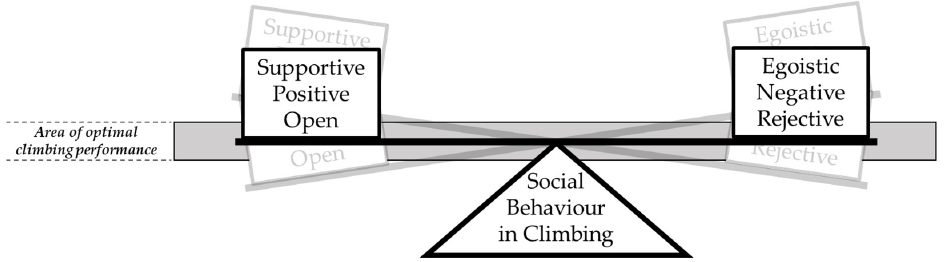
Figure 1. Concept of balanced behaviour. The bar has to be within the horizontal area to provide a setting for optimal climbing performance.